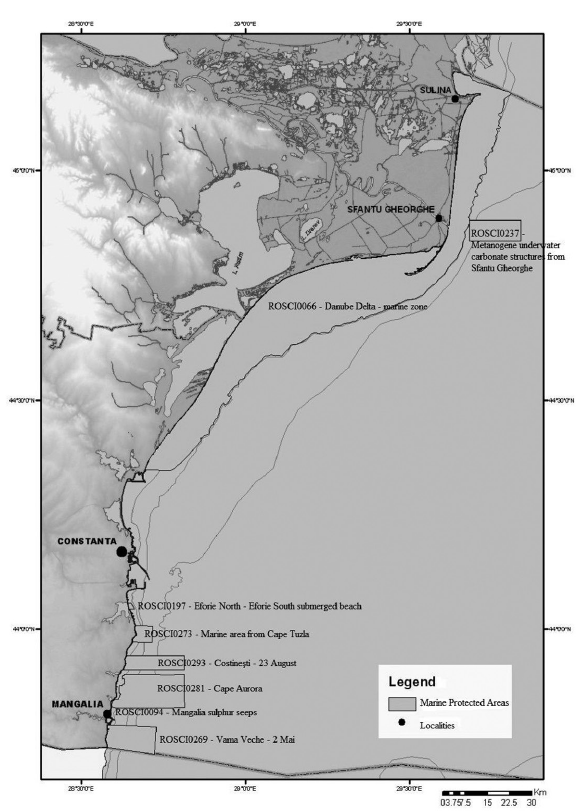
Fig. 1. – Romanian Marine Protected Areas